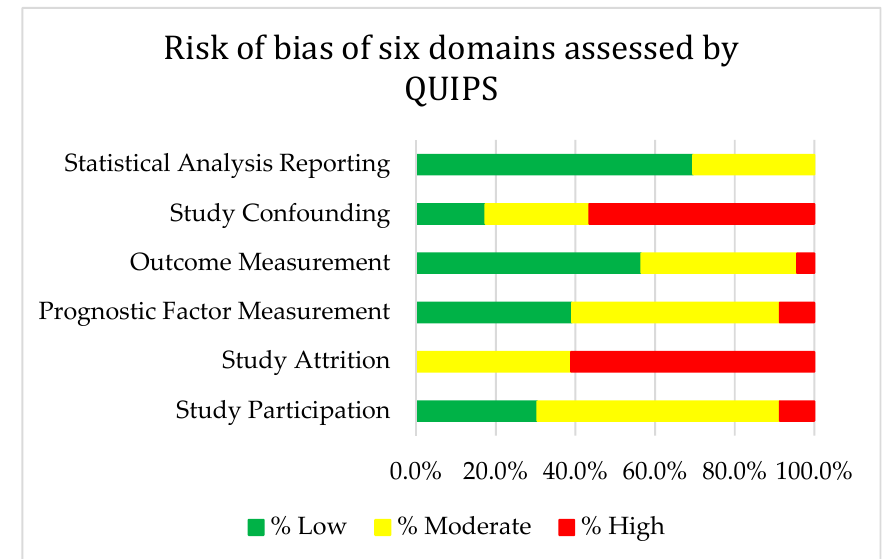
Figure A1. Risk of bias of six domains assessed by QUIPS.